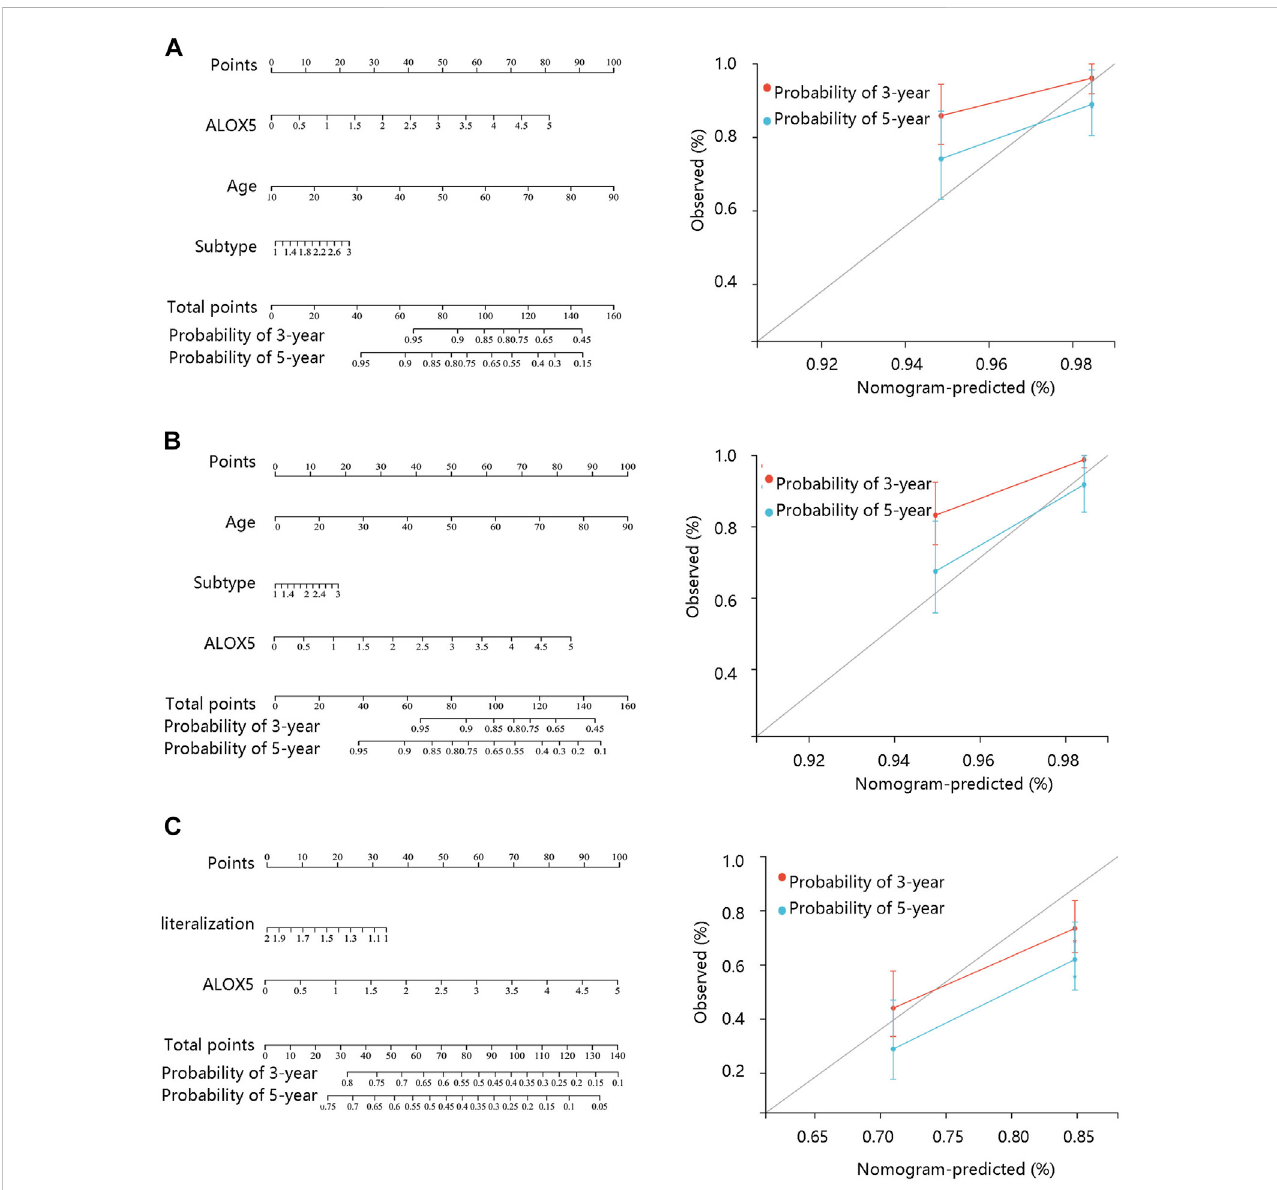
FIGURE 5 Nomogramconstructionand evaluationbased onthemultivariate Cox regression analysisresults usingtheTCGA-LGG data. Nomogram wasgenerated in terms of (A) disease-speci fi c survival; (B) overall survival, and (C) progression-free